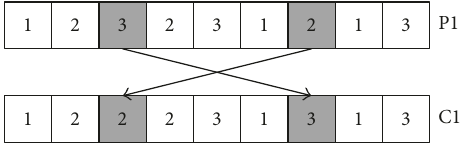
Figure 7: Mutation operation for operation part.